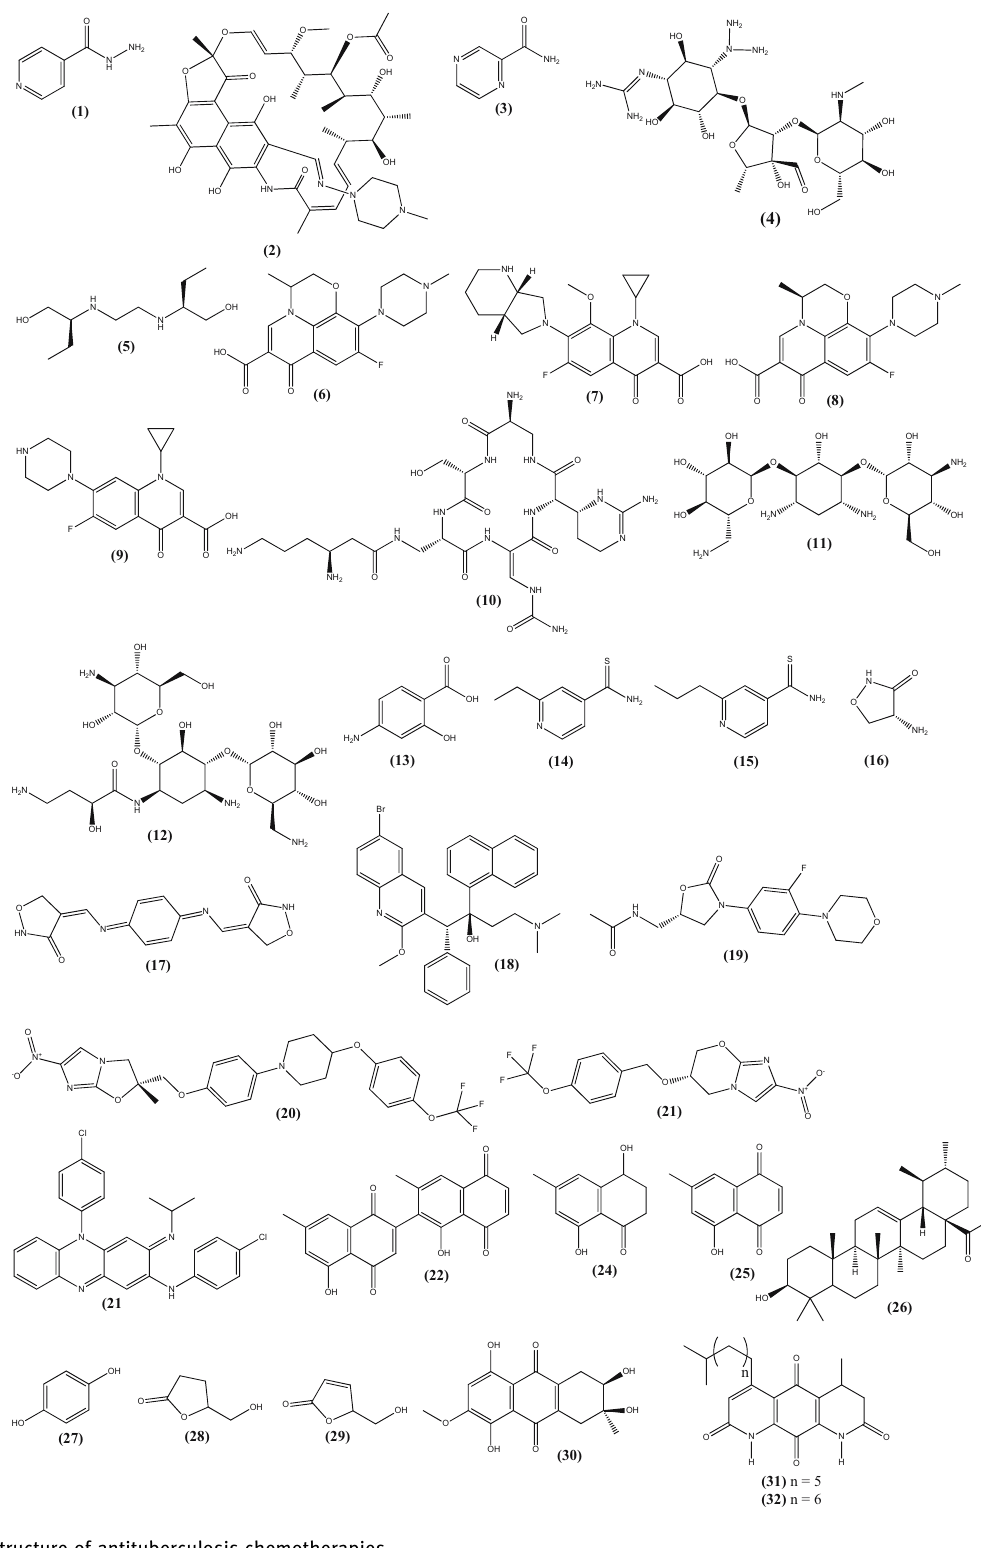
Figure 2: Structure of antituberculosis